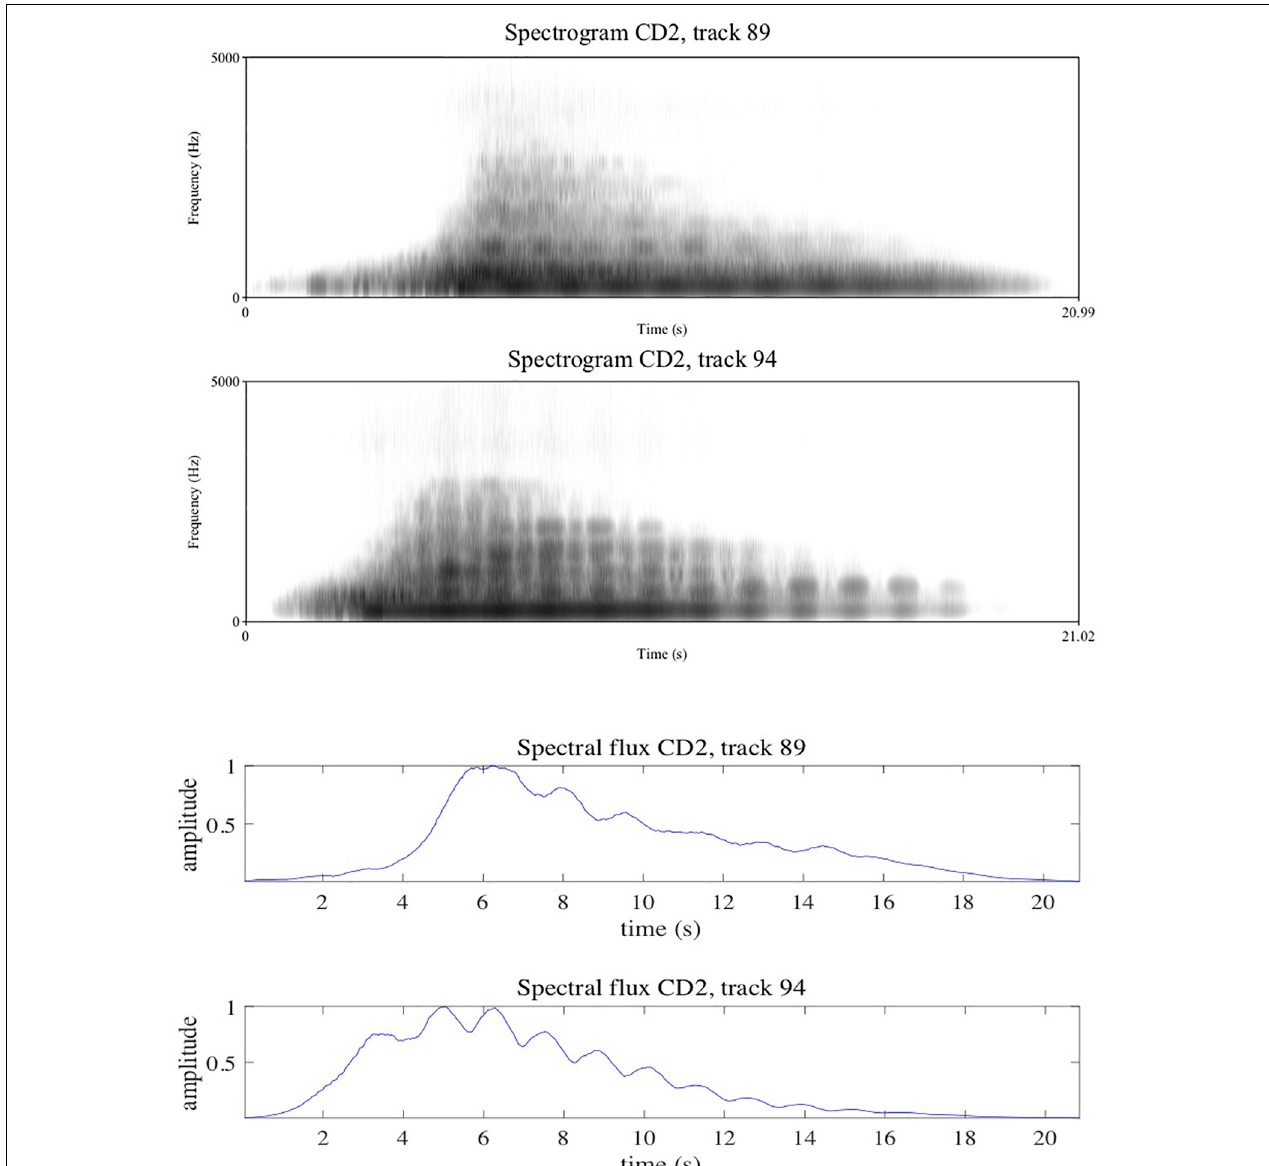
FIGURE 3 | The gait ( allure in the French original) from Solfège CD2, track 89 in the first row and track 94 in the second row, with the gait exaggerated in this second row, both shown here as spectrograms and MIRtoolbox plotting of spectral flux, i.e., plotting of changes in spectral spread, reflecting the wavy motion of the gait. The sound in track 89 is of a tremolo crescendo on a tam-tam followed by a long decay tail with the wavy gait motion at around 2 Hz, and in track 94, the same sequence of events, however, here the amplitude of the wavy gait is strongly